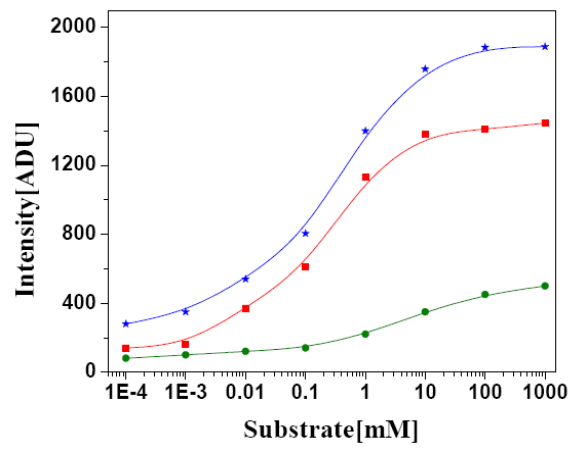
Figure 2. Response curve of the AlOx based assay for substrate determination in the presence of various concentration of substrates, such as methanol, ethanol and propanol in 0.1 M PB pH 7.5 at 35 ° C. Response time is 5 min.